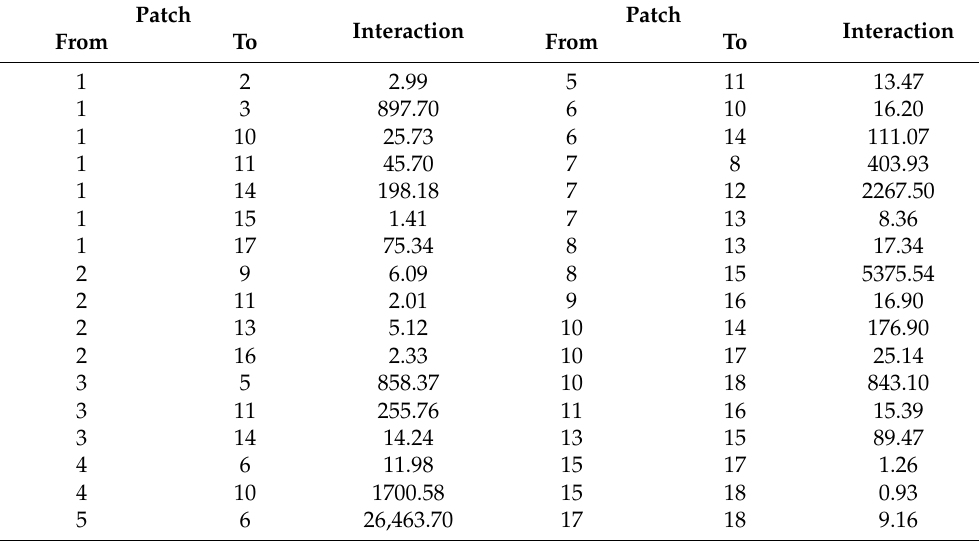
Table 9. Interaction of ecological corridors between the source patches based on gravity mode.